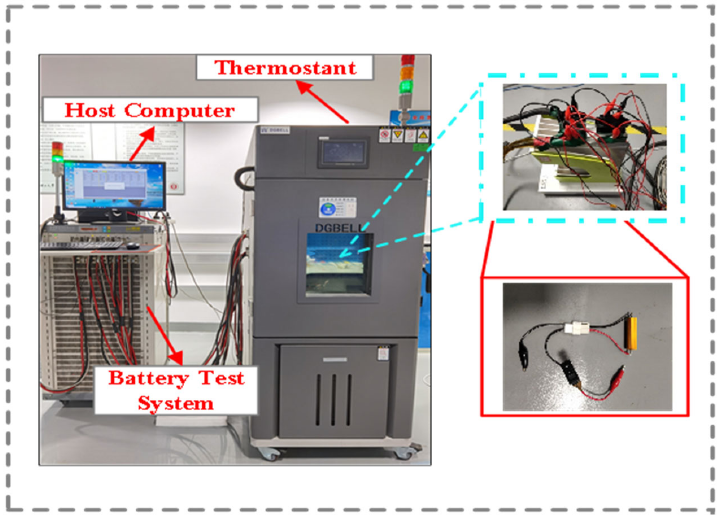
Figure 1. Simulation experiments of ISC faults within the battery module.